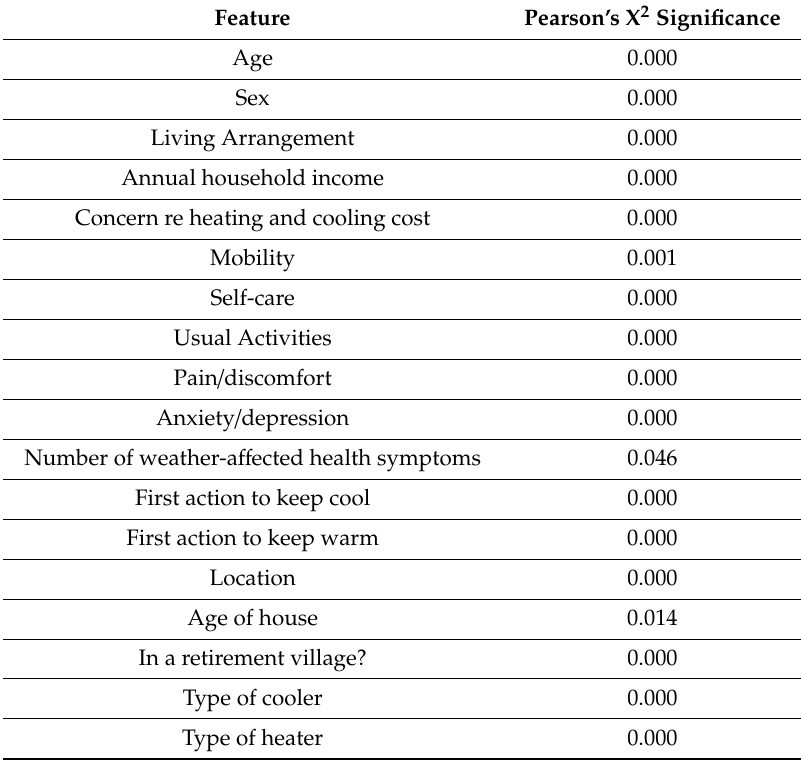
Table 2. Results of Pearson’s X 2 test for features used in cluster